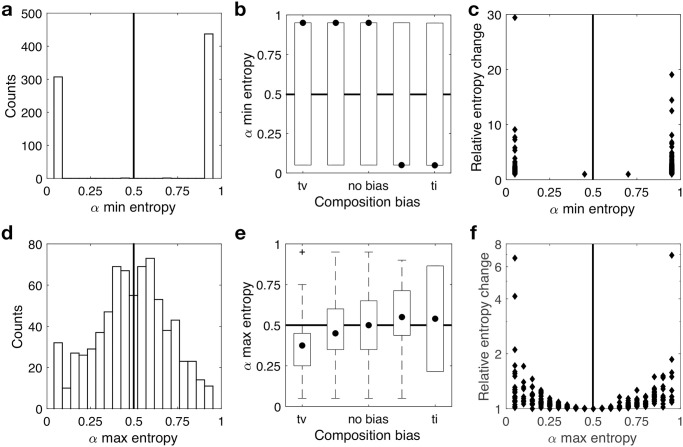
Mutation bias interacts with composition bias to impact the predictability of evolution.(a) Distribution of the mutation bias parameter α that minimizes path entropy for each landscape. (b) Mutation bias parameter that minimizes path entropy, shown in relation to composition bias. (c) Relative entropy change (entropyno bias/entropymin), shown in relation to the mutation bias parameter α that minimizes path entropy. (d) Distribution of the mutation bias parameter α that maximizes path entropy for each landscape. (e) Mutation bias parameter that maximizes path entropy, shown in relation to composition bias. (f) Relative entropy change (entropymax/entropyno bias), shown in relation to the mutation bias parameter α that maximizes path entropy. Data in all panels pertain to all 746 landscapes.